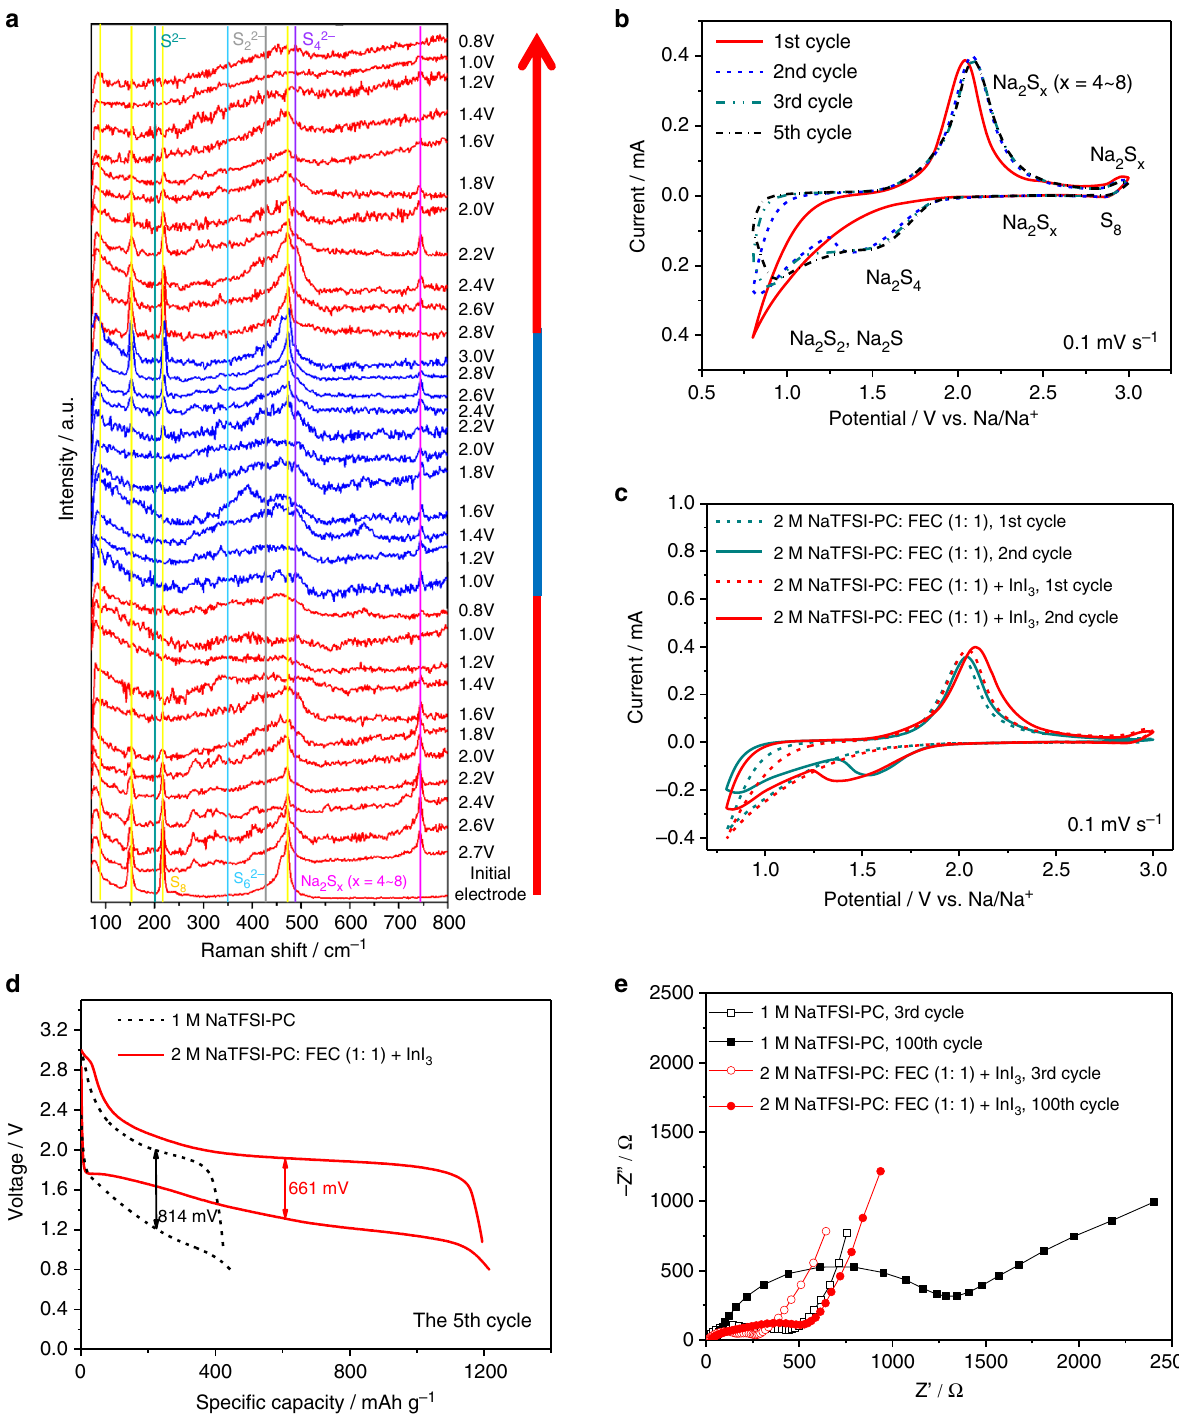
Fig. 4 Electrochemical behavior of different Na – S battery systems. a Ex-situ Raman spectra of the S@MPCF electrodes obtained from Na/2 M NaTFSI in PC: FEC with 10mM InI 3 /S@MPCF cells at different charge/discharge potentials; b The 1st, 2nd, 3rd, and 5th CV cycles of Na/2 M NaTFSI in PC: FEC with InI 3 / S@MPCF cell at 0.1mVs − 1 ; c CV curves of Na/S@MPCF cells using 2M NaTFSI in PC: FEC and 2M NaTFSI in PC: FEC with InI 3 electrolytes at 0.1 mVs − 1